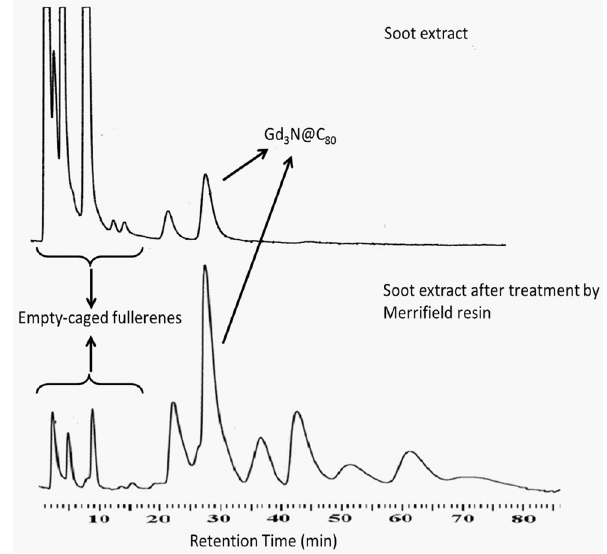
Figure 1. HPLC traces of the fullerene and metallofullerene solution before ( top ) and after ( bottom ) selective removal of empty-caged fullerenes with cyclopentadiene functionalized Merrifield resin column.